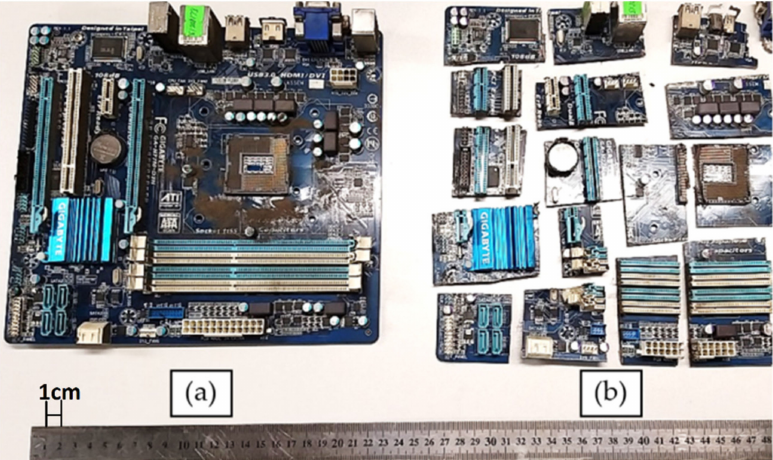
Figure 1. As-received computer motherboard ( a ) and after being cut into pieces before milling ( b ).